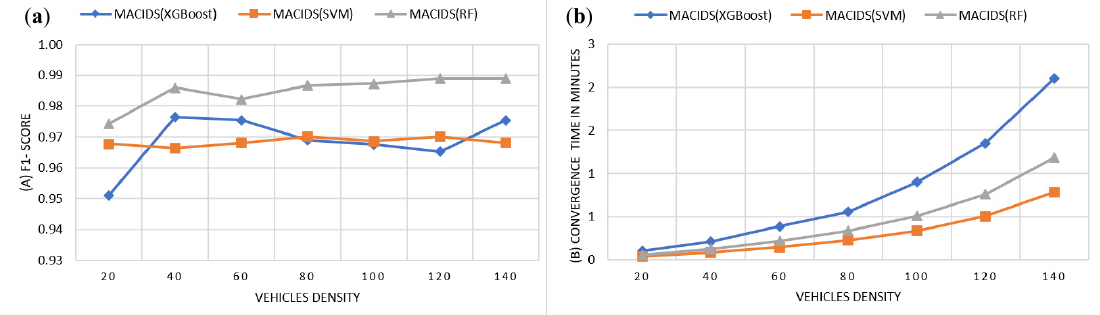
Figure 6. Impact of increasing the vehicle density on ( a ) the detection performance and ( b ) Figure convergence time.